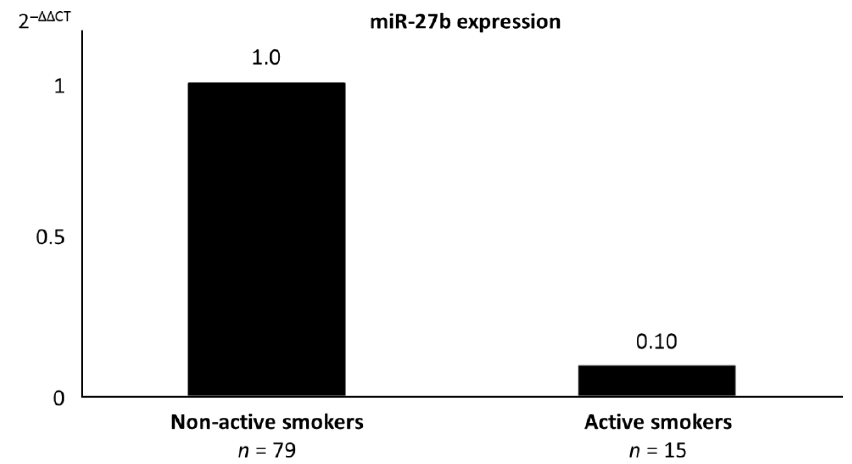
Figure 1. Relative expression of miR-27b according to the cigarette-smoking status. The relative expression of miR-27b (2 − ∆∆ Ct ) is presented for non-active smokers, including never smokers and prior smokers, and for active smokers. Table 3. Predictors of peripheral artery disease in multivariate logistic regression analysis.